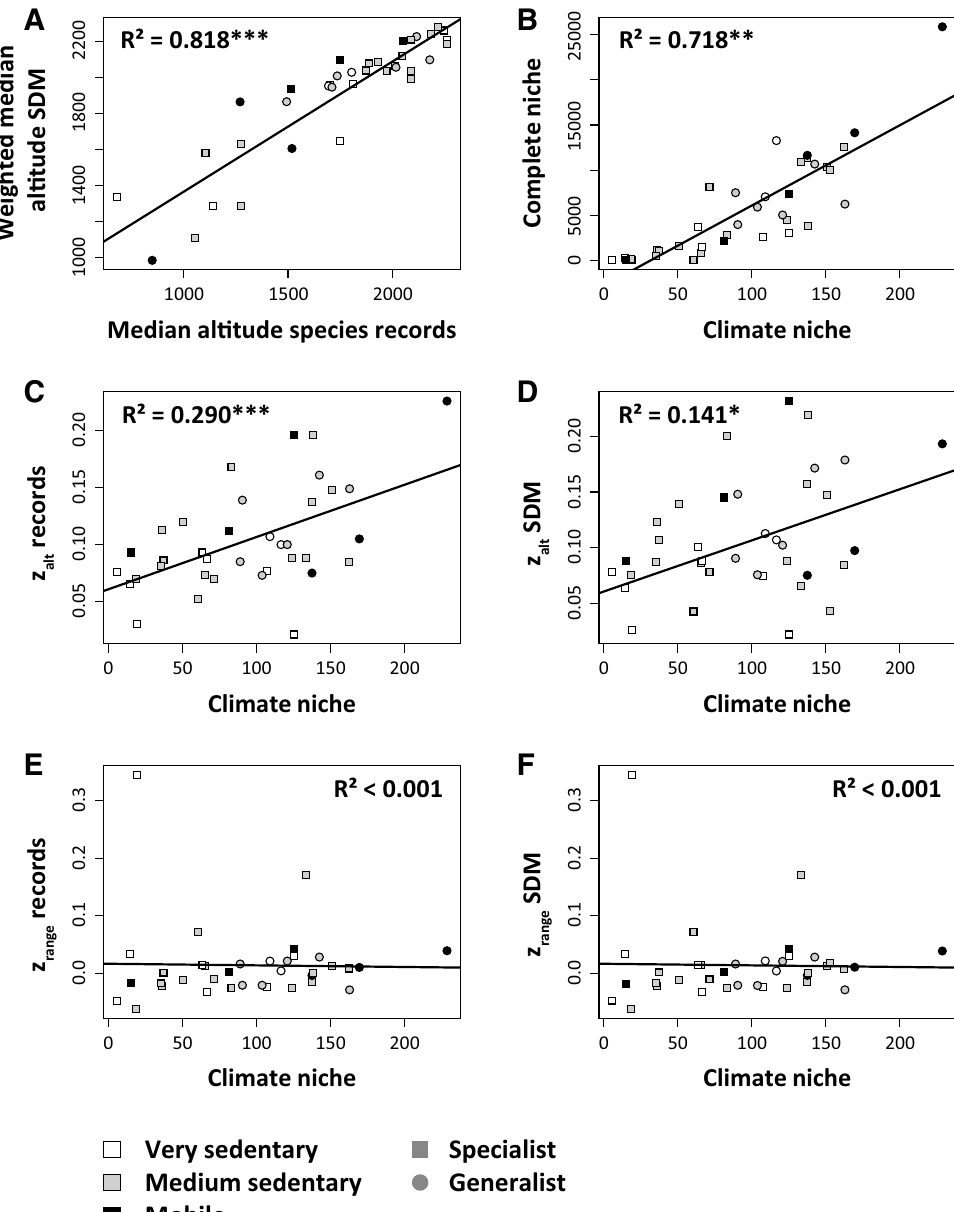
Figure 3. Relationship between median altitude of species records and median altitude derived from the species distribution models weighted by probability ( A ). Relationship between the niche volumes computed based on climatic components only and both climate and topography ( B ). Slopes of altitudinal shift z alt increased with increasing climate niche using both the species records ( C ) and the median altitude per species weighted by SDM probability ( D ). Slopes of range size shifts z range showed no correlation with the climate niche volume using both species records and SDM results ( E, F ). R 2 : coefficients of variation of ordinary least squares regression. Parametric significances: * P < 0.05, ** P < 0.01, *** P <